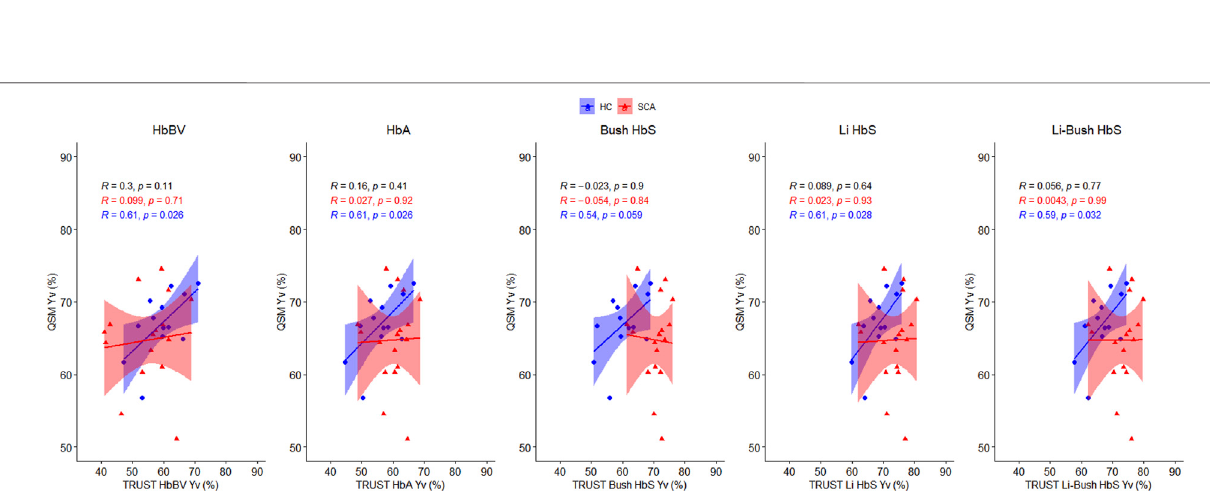
Table 2 . Steady state HbF concentrations were available in 13/ 17 participants with SCA, steady state absolute reticulocyte count (ARC) in 8/17 and lactate dehydrogenase (LDH) levels in 15/17 ( Table 2 ). Compared with our cohort study (Stotesbury et al., 2022), the proportion of patients with SCA and SCI and the rates of hydroxyurea and blood transfusion treatment were similar.